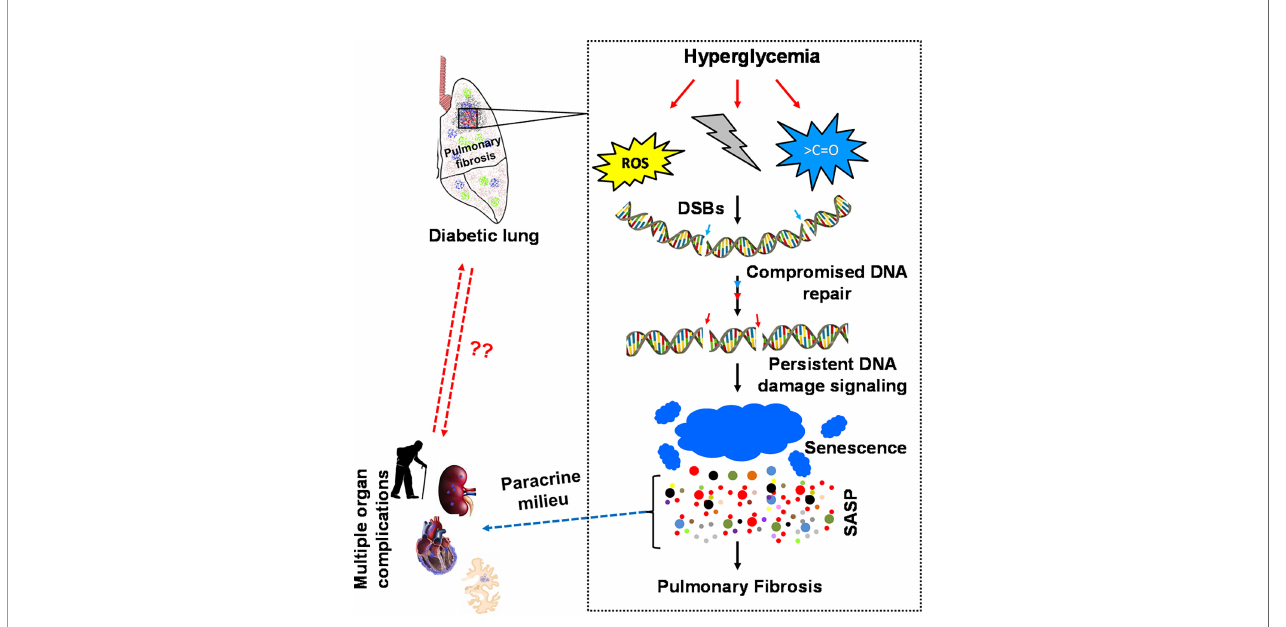
FIGURE 2 | Diabetes-associated persistent DSB signaling, senescence and SASPs modulates the normal repair of idiopathic pulmonary fi brosis. Diabetes- associated perturbed cellular metabolism is cumulatively linked to diabetic pneumopathy. Elevation of ROS, disturbed NAD + /NADH equilibrium, and non-speci fi c modi fi cations of active biomolecules affect the integrity of the genome and the kinetics of DNA repair. The absence of timely DNA repair activates persistent DNA damage signaling, followed by an irreversible cell cycle arrest, cellular senescence and senescence-associated secretory phenotype (SASP). The SASP releases various pro-in fl ammatory cytokines such as IL-1 a / b , IL-6, IL-8, TGF- b , ICAM, Mcp1 & TNF- a . These cytokines act autocrine and paracrine by altering the cellular homeostasis to maladaptive genetic transformations resulting in severe in fl ammation and organ fi brosis. The cytokines released from the SASP zone, such as IL-6, IL-8 and TGF- b , activate the fi brotic program via the JAK-STAT pathway. Therefore, the accumulated ECM compromises the functional integrity of diabetic lungs and transforms the parenchymal organ to idiopathic pulmonary fi